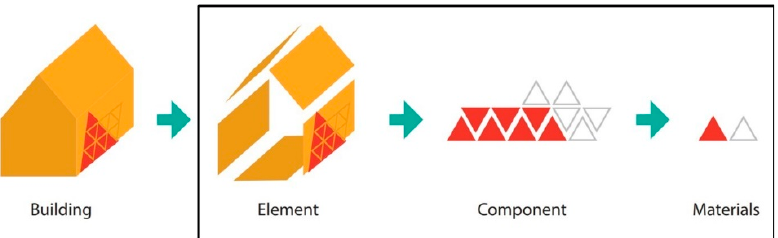
Figure 4. The hierarchical levels of analysis [36]. This study only considers the levels in the black rectangle. black